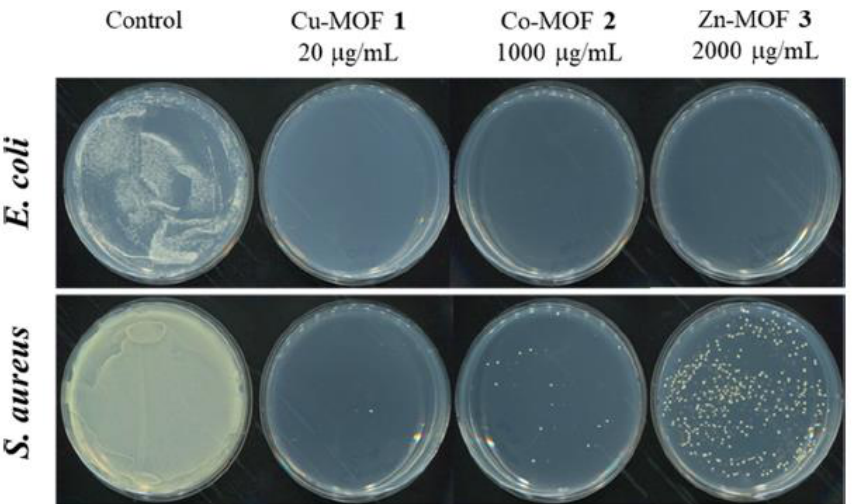
Figure 9. Assessment of antibacterial effects after 24 h of incubation by colony-forming assay on agar plates treated with MOFs ( E. coli and S. aureus at 10 8 and 10 7 cfu mL − 1, respectively). Reprinted with permission from ACS Appl. Mater. Interfaces 2020, 12, 20234−20242. Copyright 2020, American Chemical Society [48].